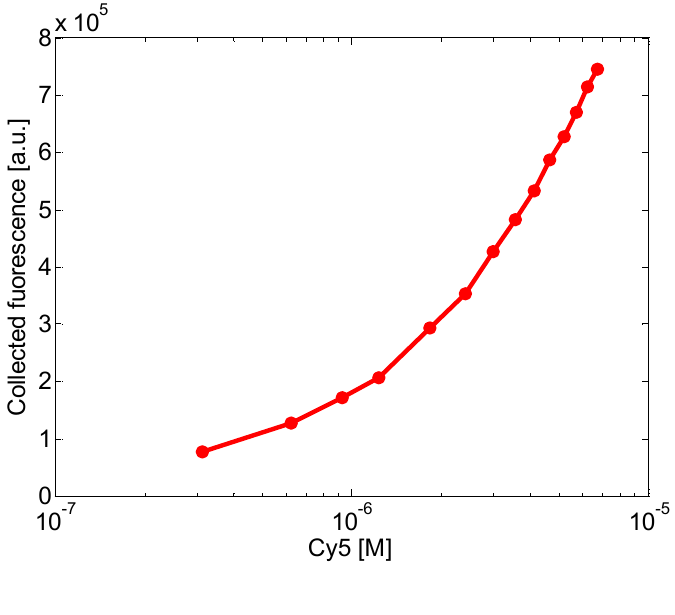
Figure 11. Fluorescence collected for a sample concentration in the 3.14 × 10 − 7 M to 6.76 × 10 − 6 M